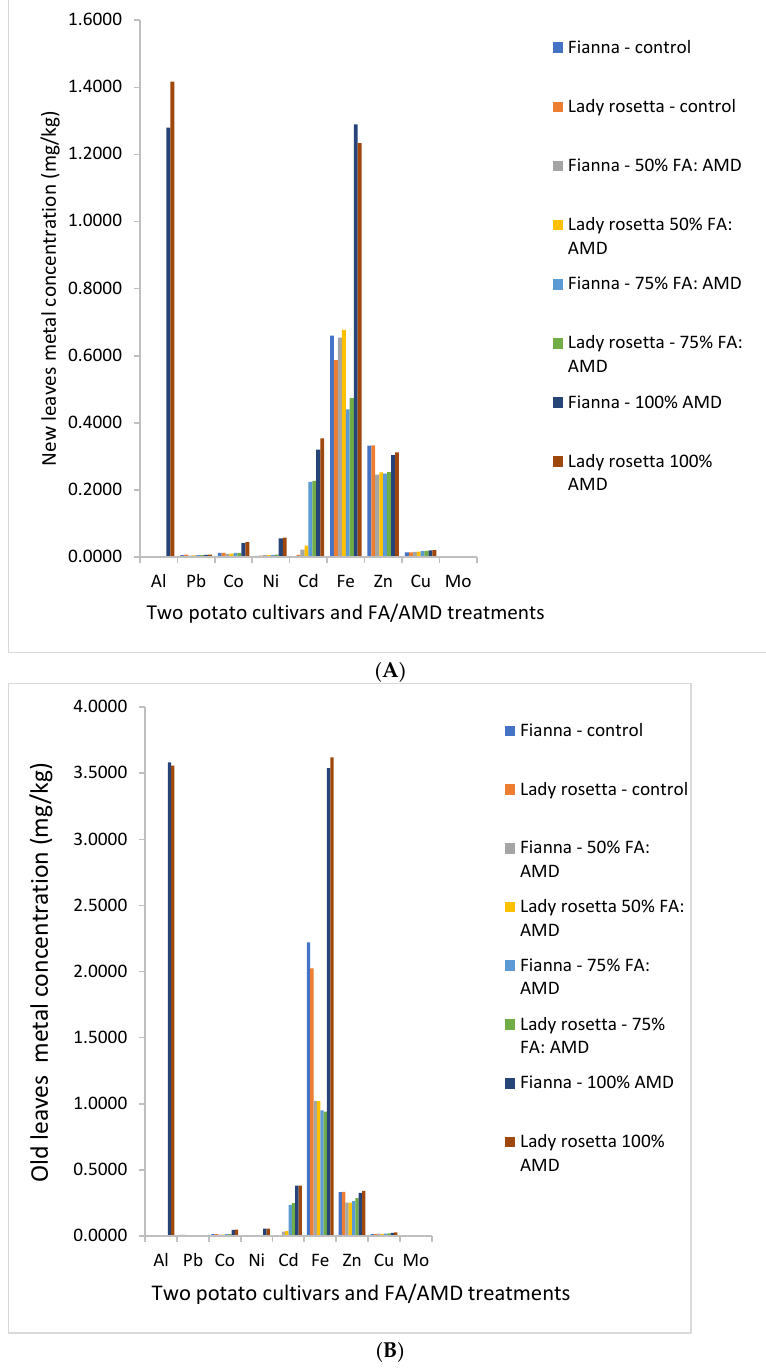
Figure 3. Concentration of heavy metals in the new leaves ( A ) and old leaves ( B ) during growth of Fianna and Lady rosetta cultivar irrigated with acid mine drainage.